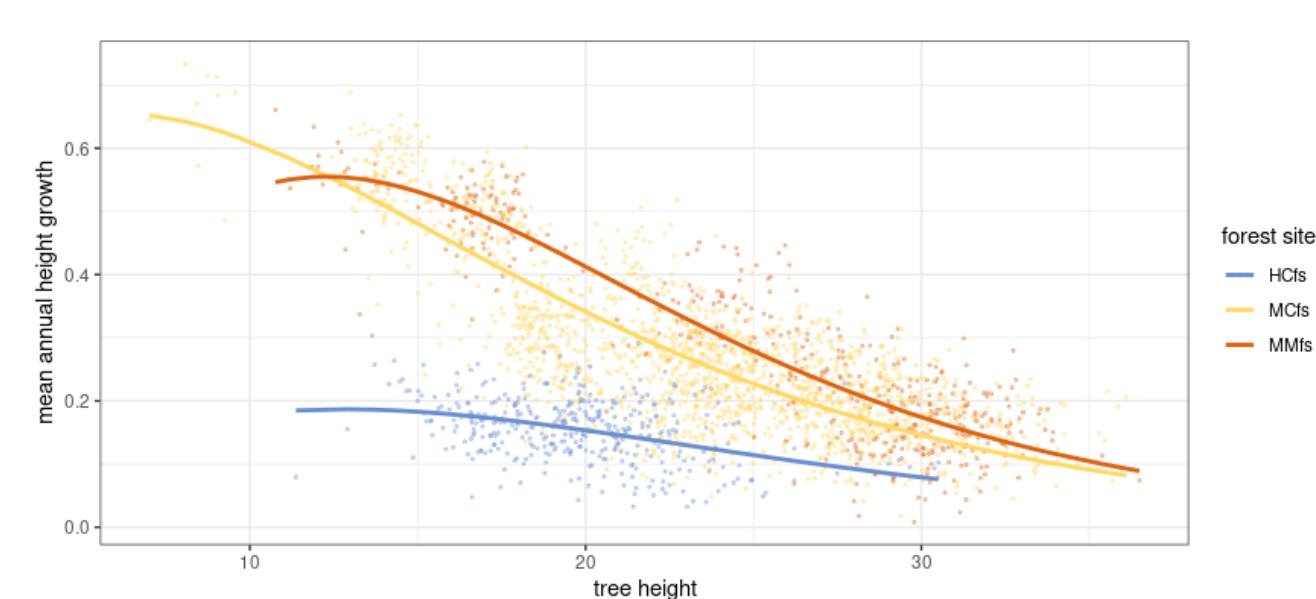
Table 3. The parameters and statistics of fitted Gompertz function to model the growth of the height for a given initial tree height. Statistically significant parameters of the function are in bold ( p -value < 0.05).